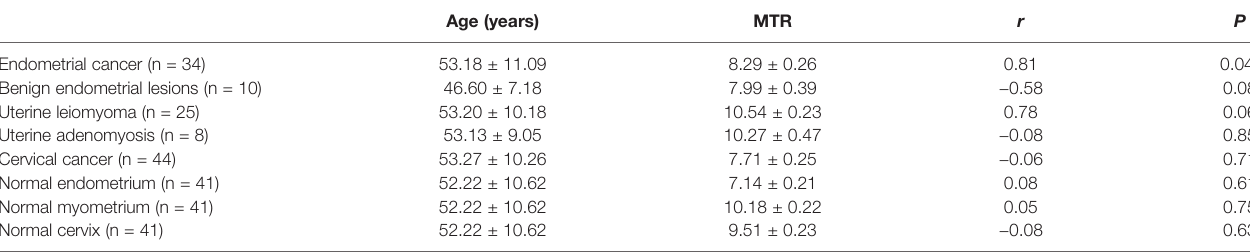
MTR, magnetization transfer ratio. *, P <